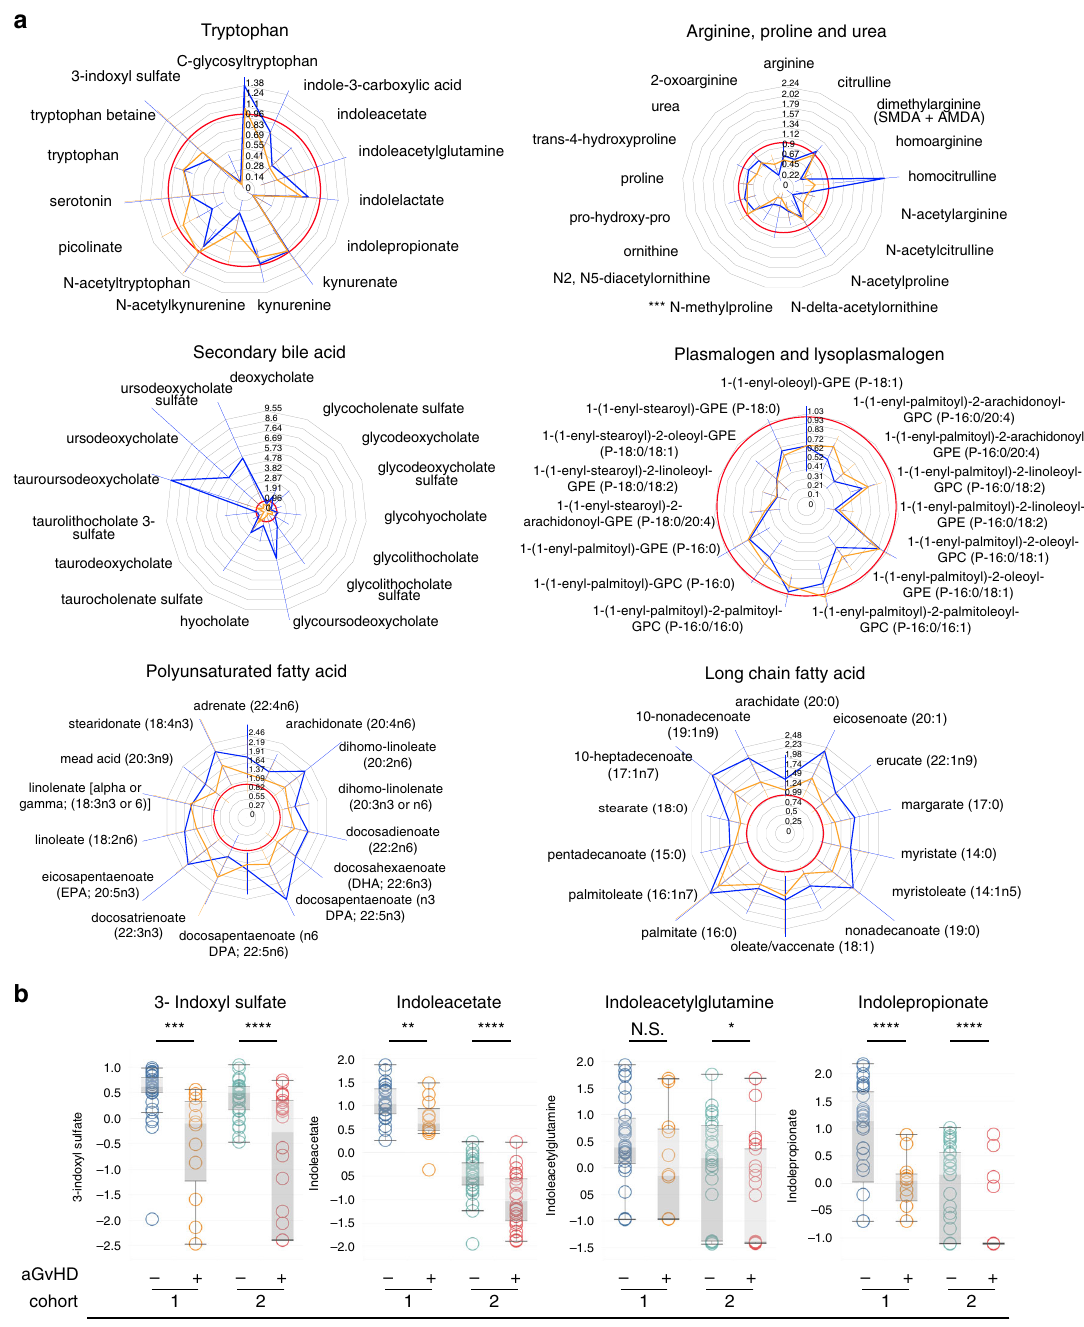
A metabolite was declared to be signi fi cantly more frequently undetectable in one group (hence, present at signi fi cantly lower amounts in patients of that group) when the test was signi fi cant after Bonferroni correction for multiple testing. For the D vs Rs analysis, all the 653 metabolites were analyzed, leading